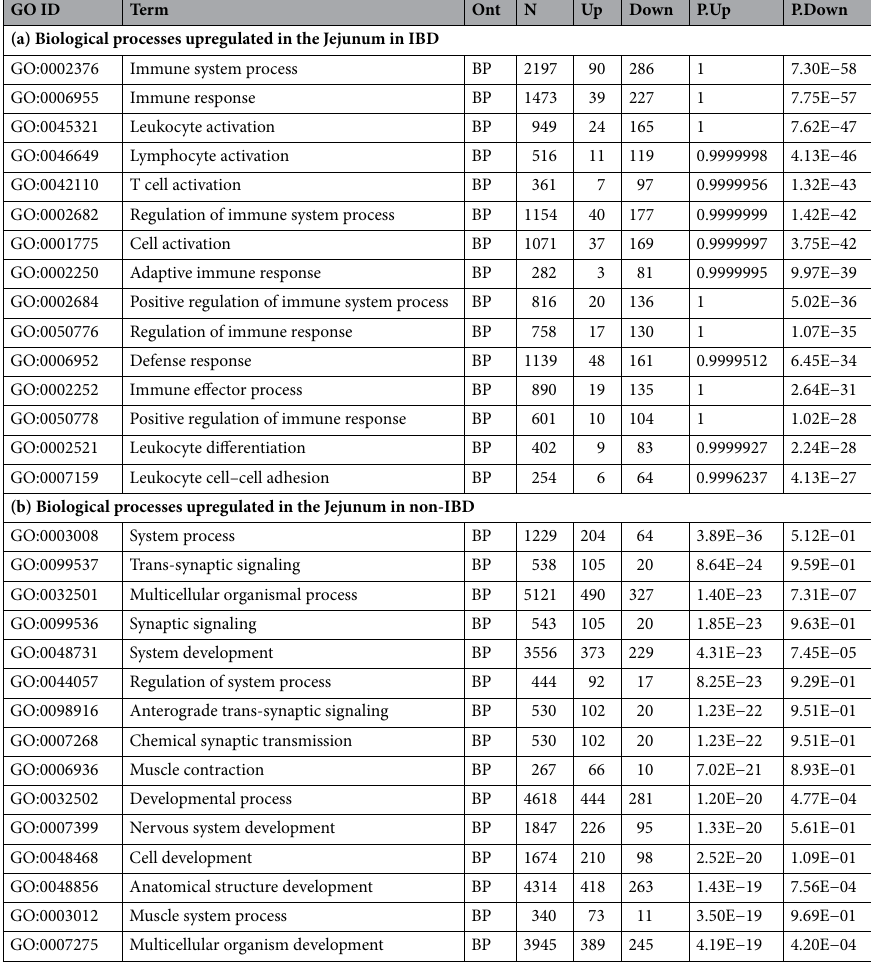
Table 2. Top gene ontology sets in